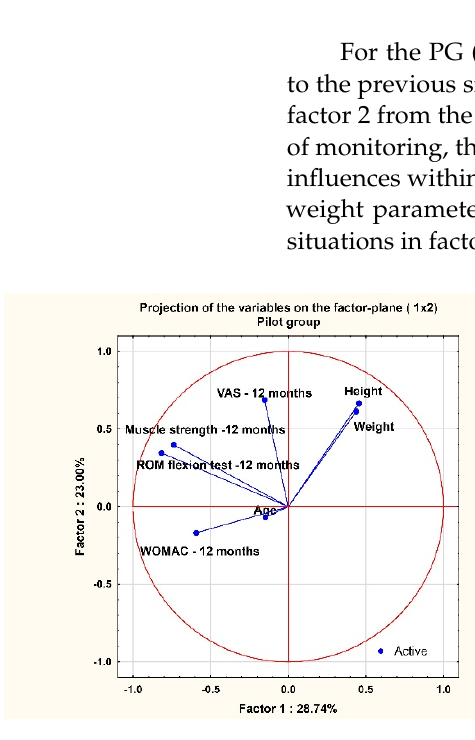
Table 15. Factor coordinates of the variables based on correlations with the control group (CG) after 9 months.